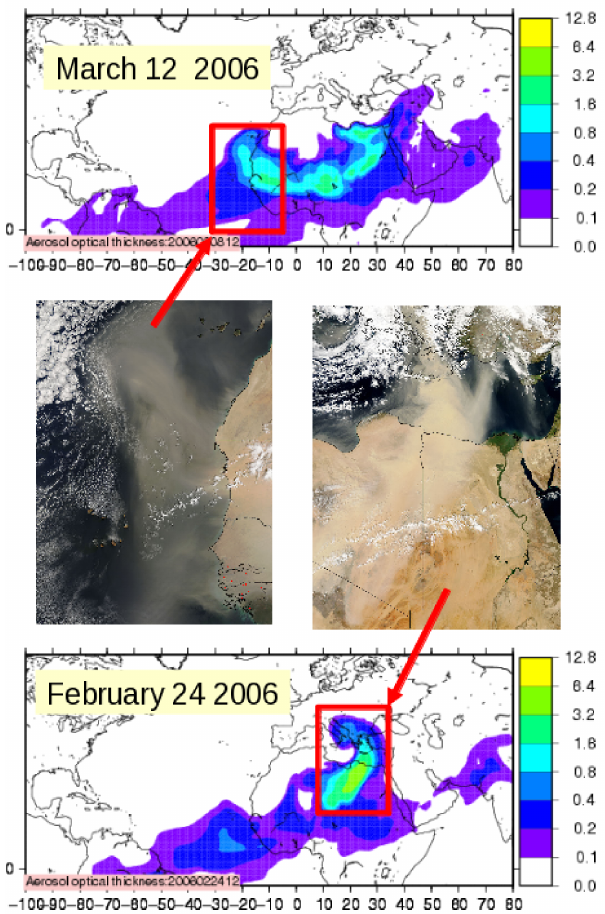
Fig. 10. Example of dust plumes observed and simulated for the 24 February and 8 March 2006 with CHIMERE. Satellite images are from NASA/MODIS.